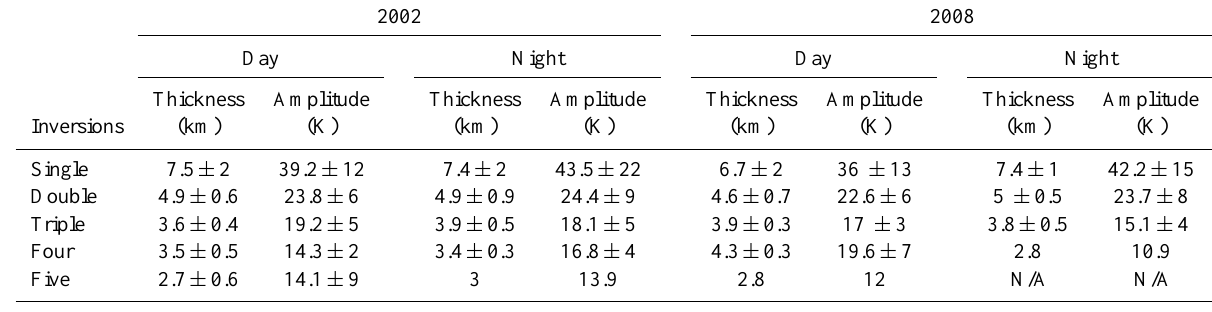
Table 2. The amplitude and thickness of multiple mesospheric inversion layers observed in the years 2002 and 2008 together with their standard deviations depicting the variability.